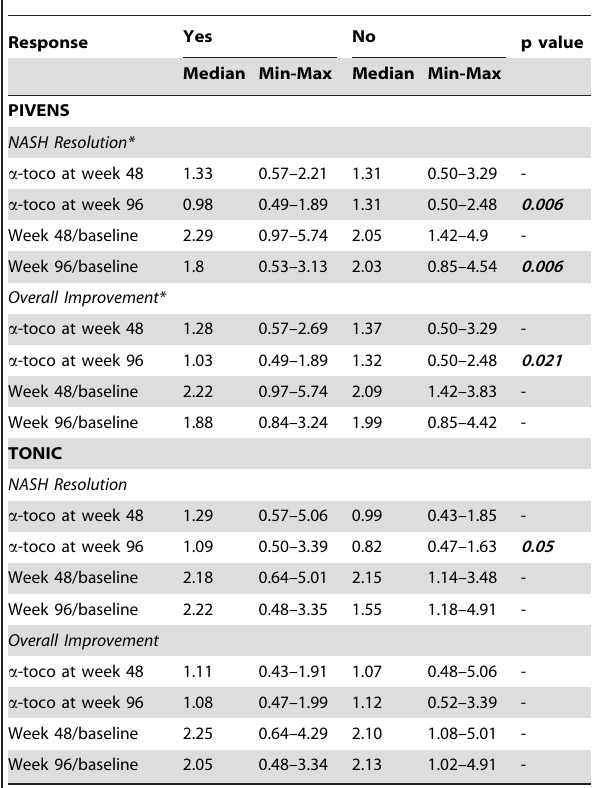
Table 2. Association between a -tocopherol level during treatment and histological endpoints among Vit E treated participants in PIVENS and